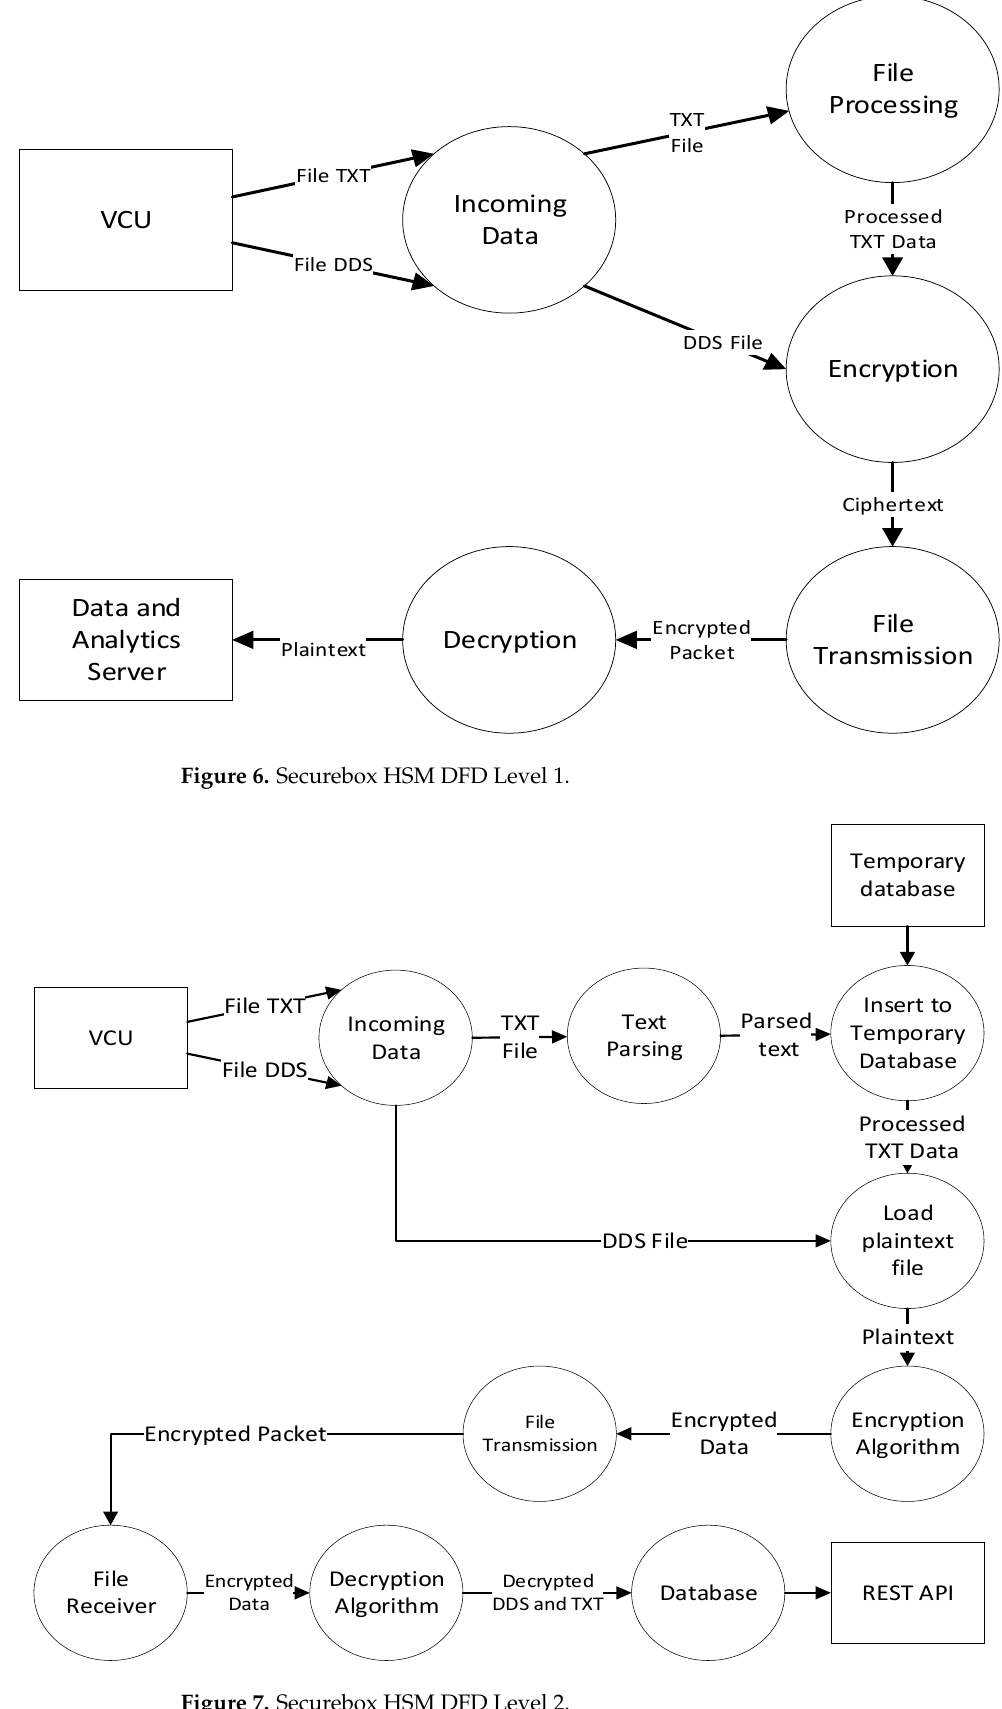
Figure 7. Securebox HSM DFD Level 2.